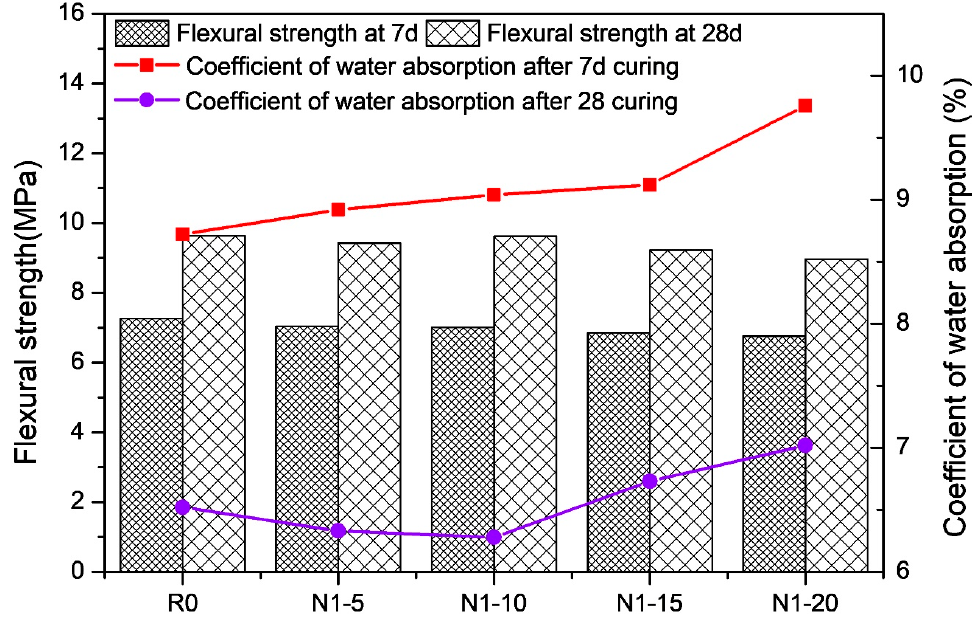
Figure 5. Flexural strength and coefficient water absorption of different ratios of RHA-cements at 7 and 28 d.